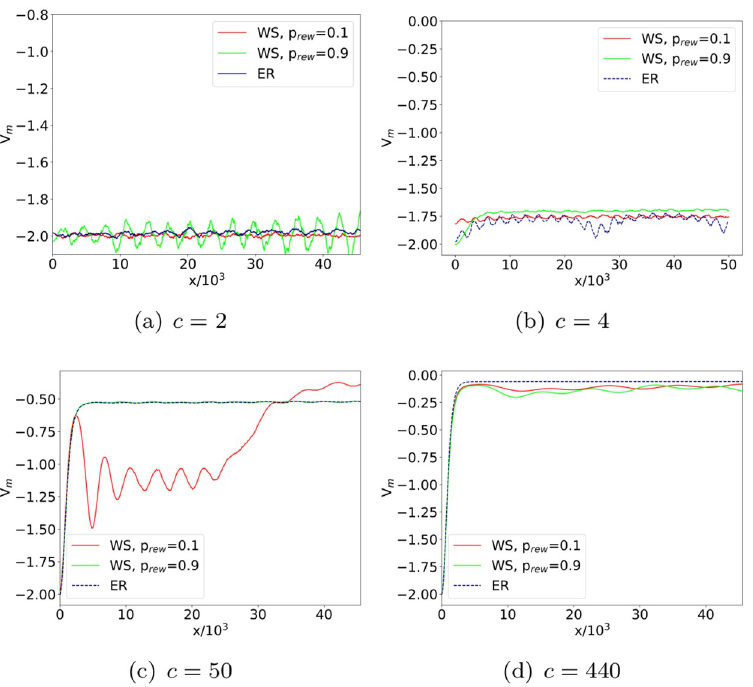
Fig 5. WS and ER ensemble potentials. Direct comparison of ensemble potentials V m reconstructed from 100 realizations of WS and ER networks with the same average degree c . Remarkable discrepancies between the two models emerge at intermediate values of c , provided that the rewiring probability of the WS construction is sufficiently small.